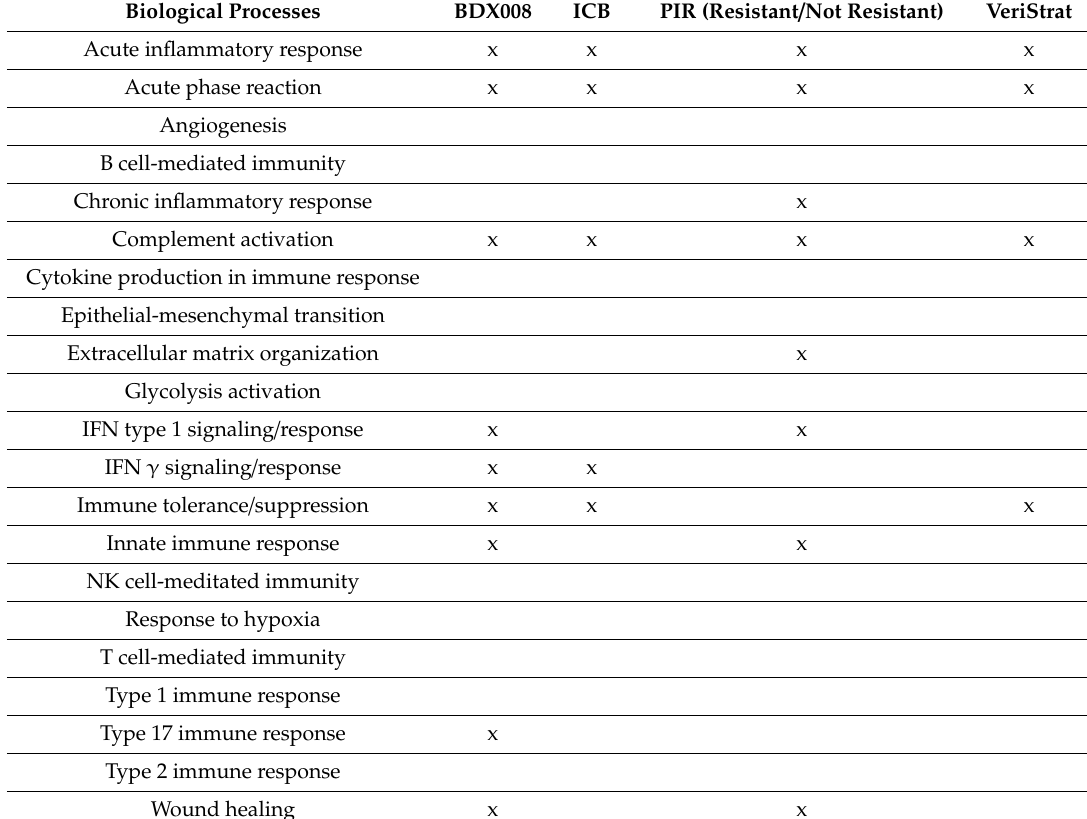
Table 3. Associations between proteomic tests and biological